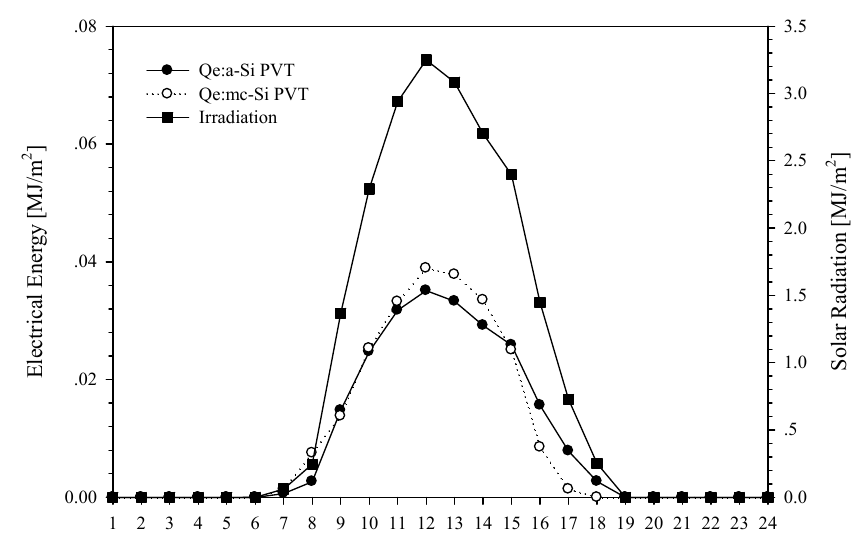
Figure 9. Daily electrical production of PVT systems.